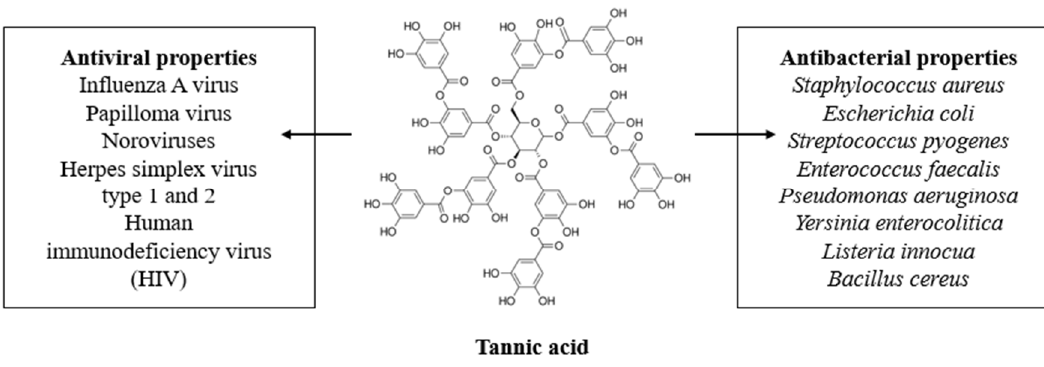
Figure 1. The tannic acid structure and its antimicrobial properties.